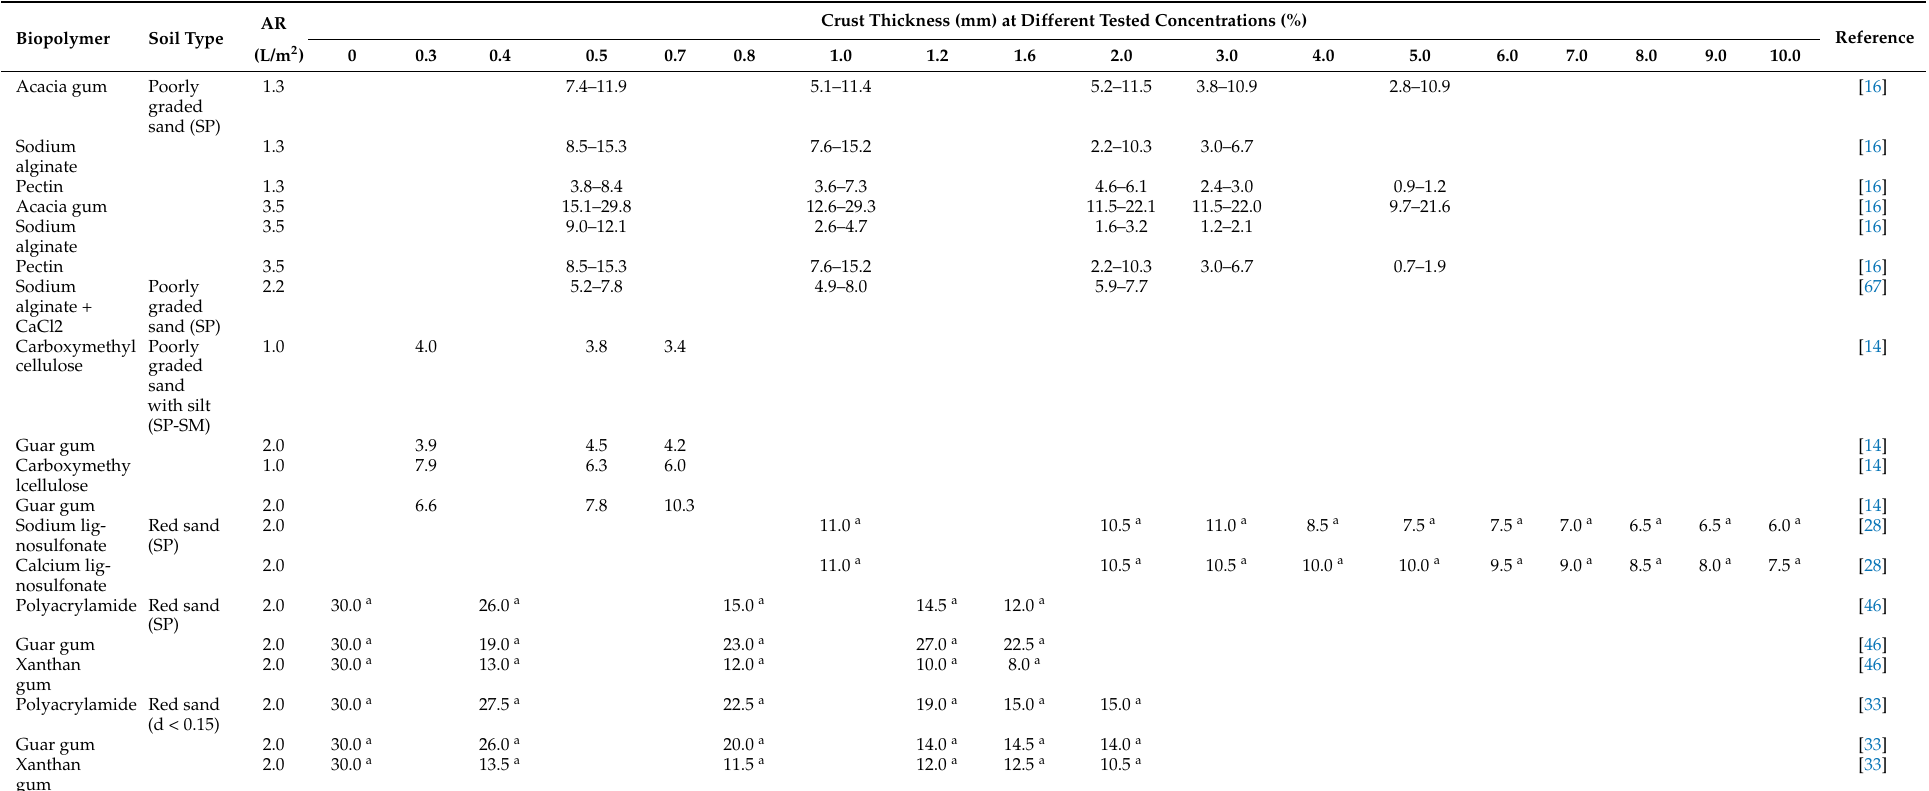
Table A9. Compilation of results from previous studies analysing the crust thickness of biopolymer-treated